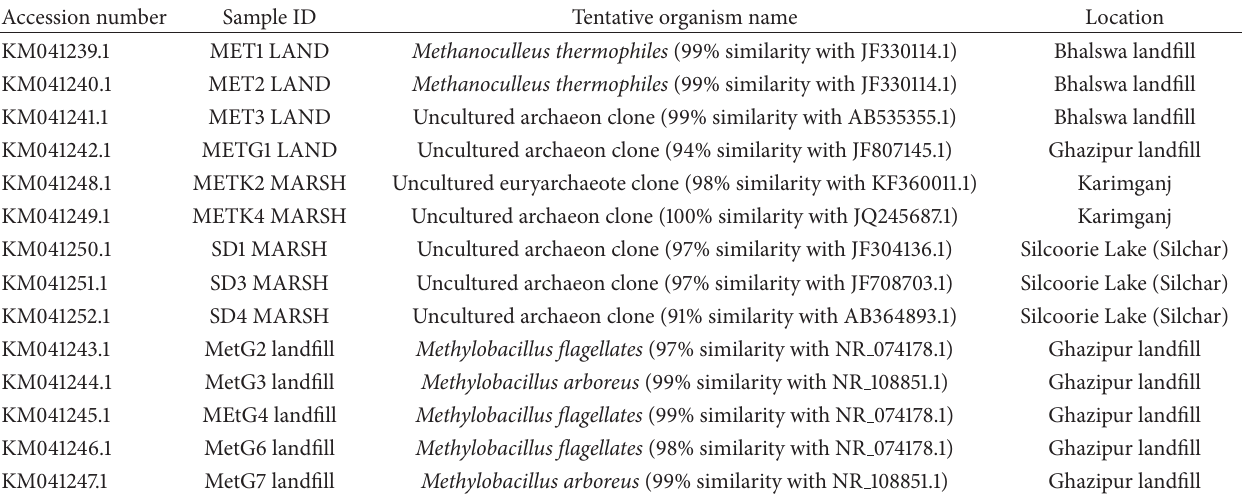
Table 4: List of accession numbers of the sequences submitted in NCBI and their percent similarity with database along with the sampling